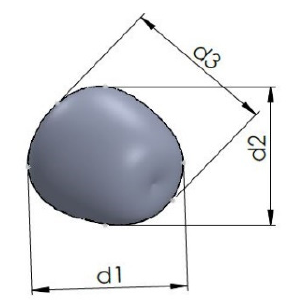
Figure 1. Schematic for measuring the geometrical parameters of a fertilizer granule.